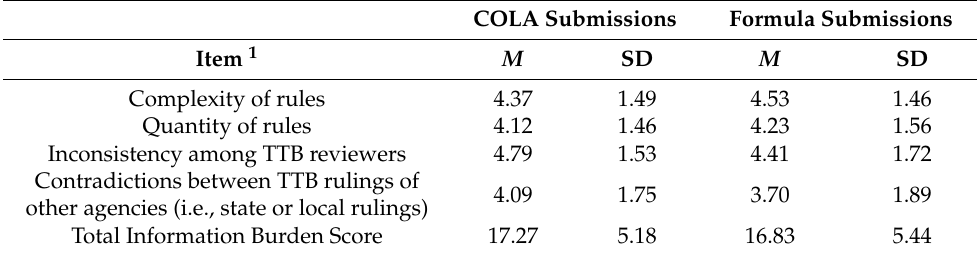
Table 12. Information Burden Associated with COLA and Formula Submissions.